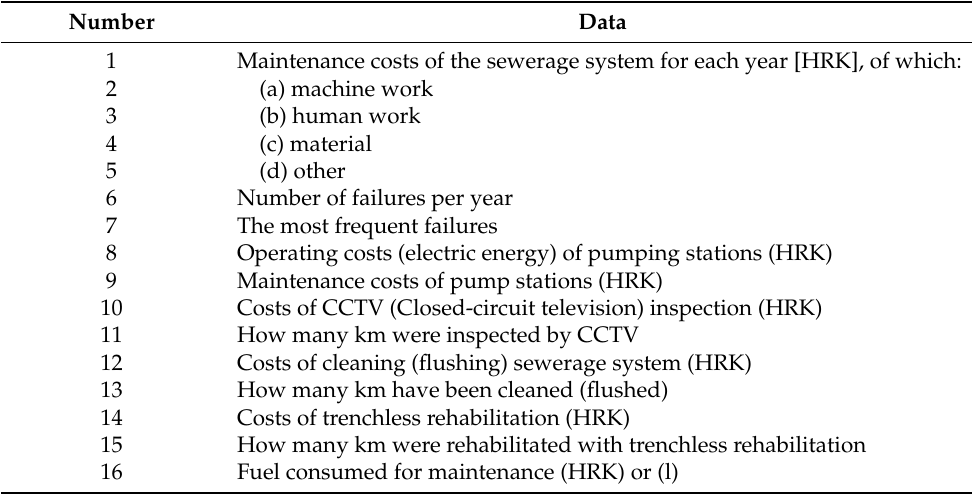
Table 2. Developed data structure and maintenance costs of sewerage system.